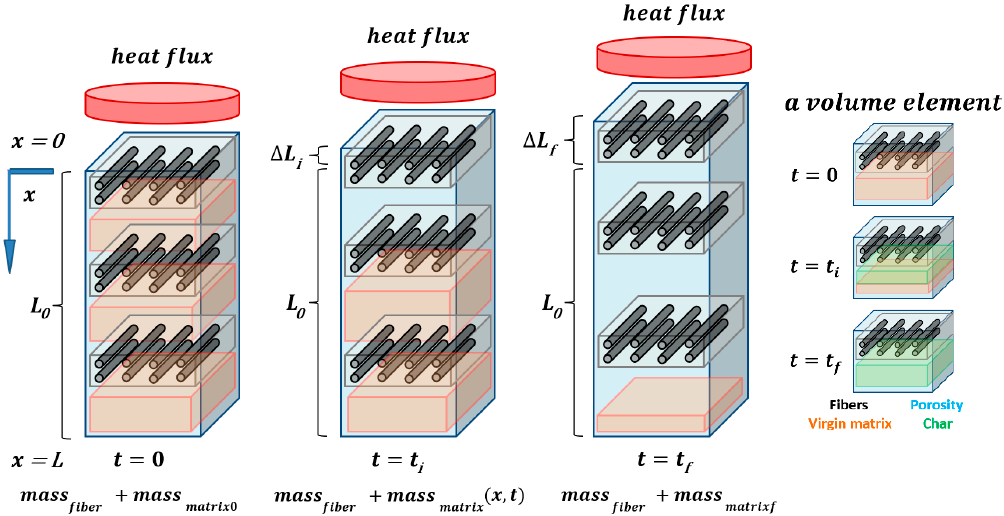
Figure 1. Schematic of thermal expansion modeling of a laminated composite material.